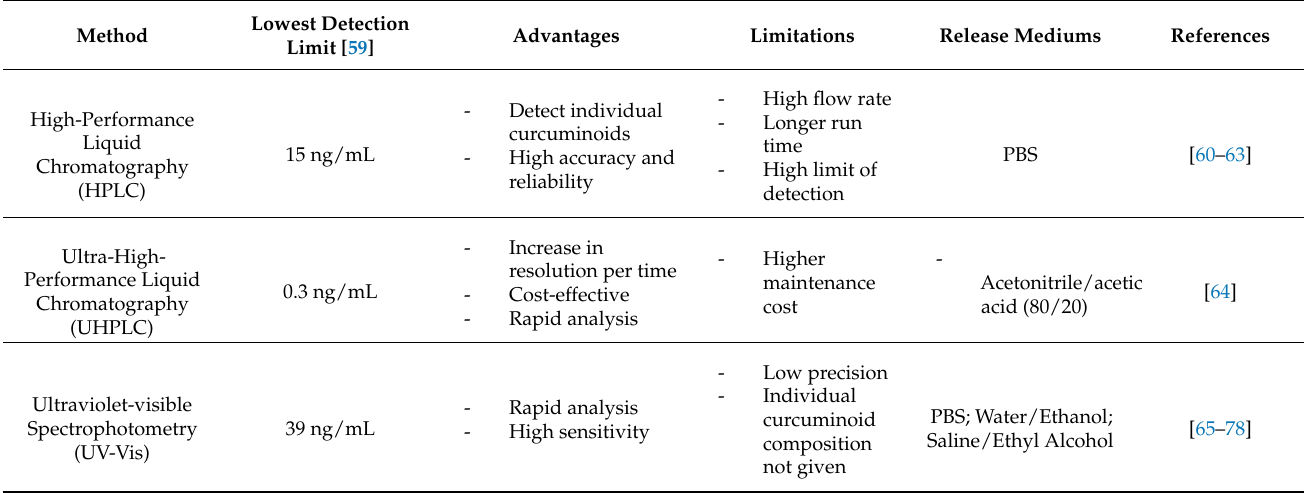
Figure 2. Schematic of the keto-enol tautomerism that takes place within curcumin with intermediate steps shown. Each form is predominant under specific conditions and possesses different properties. Table 1. Advantages and disadvantages of analytical quantification methods for